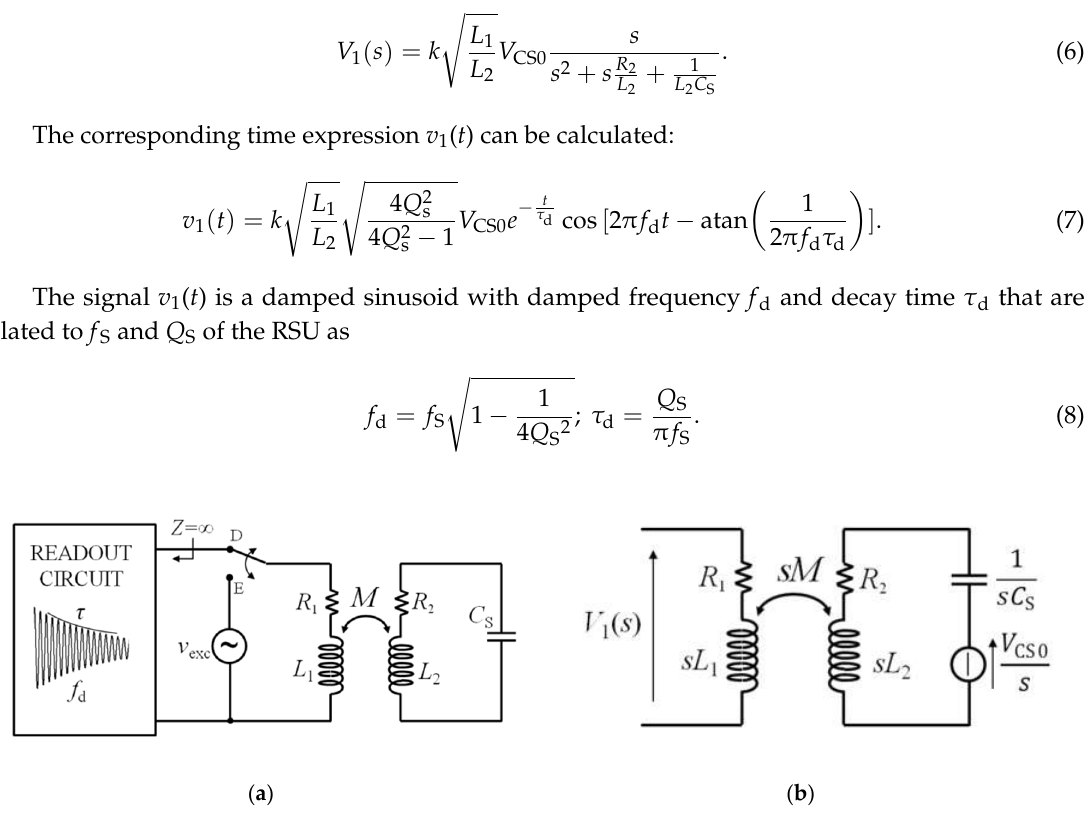
Figure 5. ( a ) Block diagram of the time-gated technique; ( b ) equivalent circuit of the time-gated technique during the detection phase.